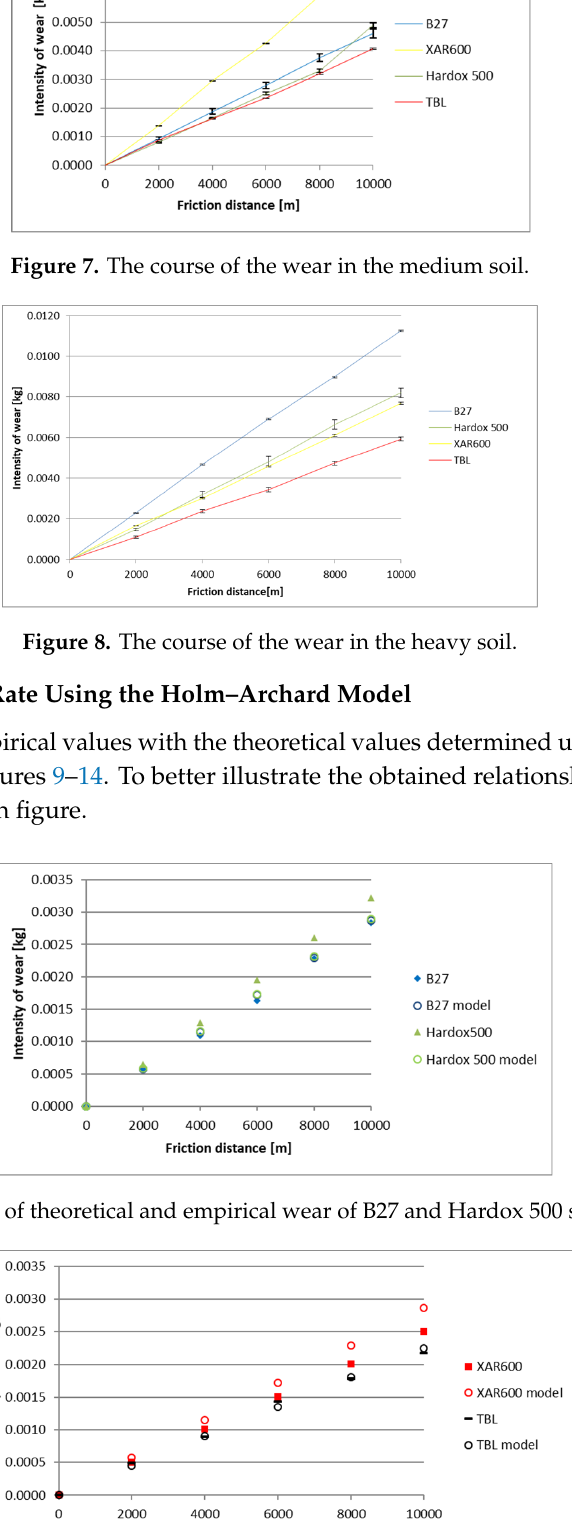
Figure 10. The course of theoretical and empirical wear of XAR 600 and TBL steels in light soil.